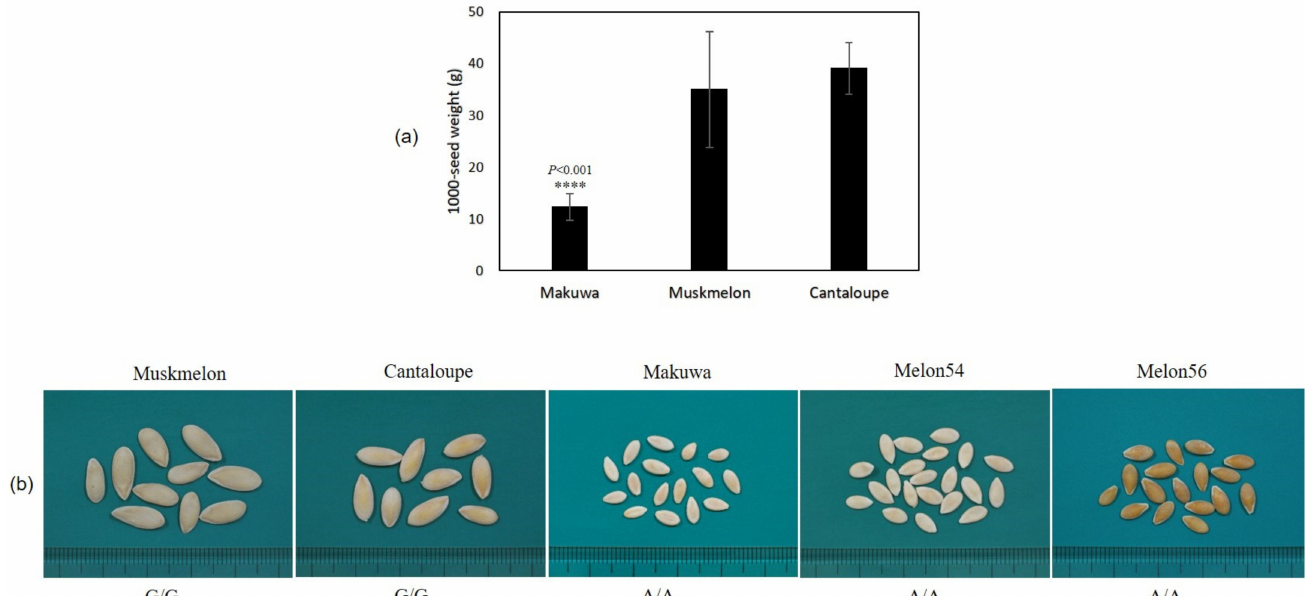
Figure 6. Variation in agronomic trait of 1000-seed weight (TSW) among melon varieties ( a ) and the genotype frequency at the single nucleotide polymorphism (SNP) locus S6_5912593 ( b ) in the melon varieties of the present